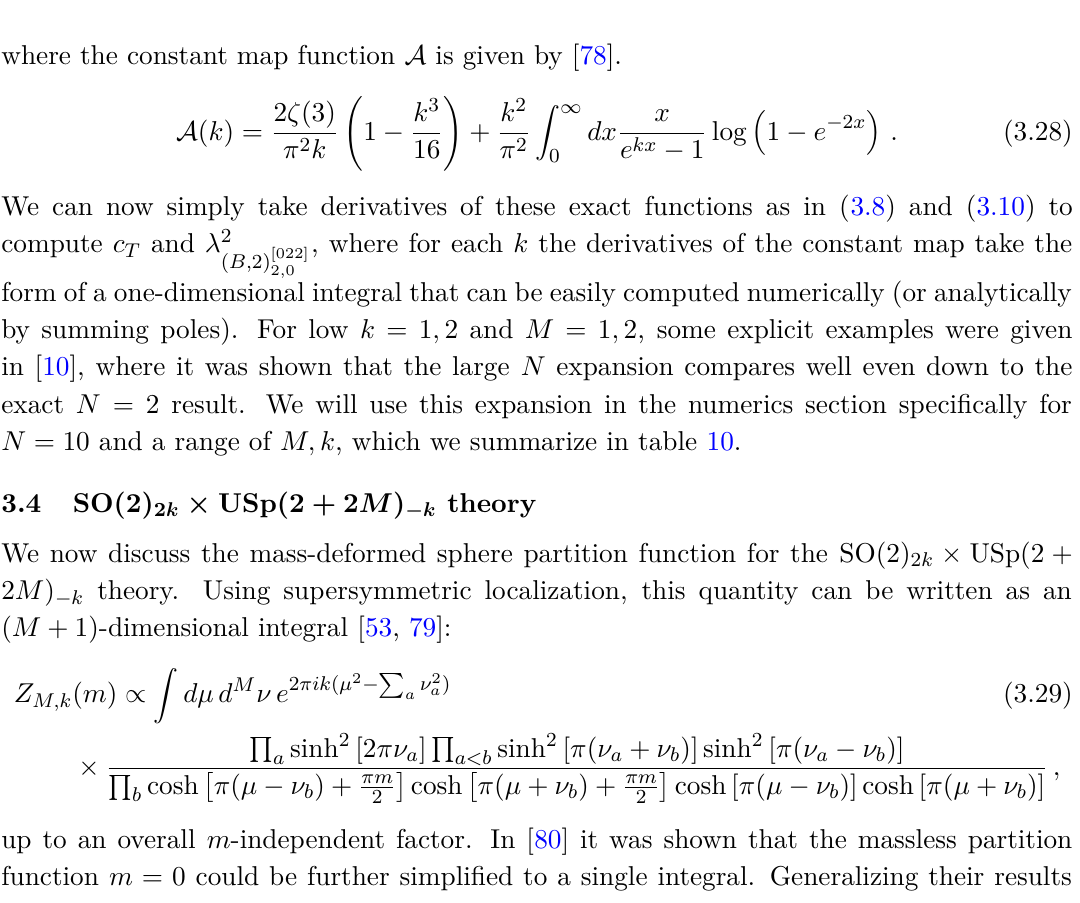
Table 10 . OPE coefficients 16 computed from the all orders in 1 /N formula